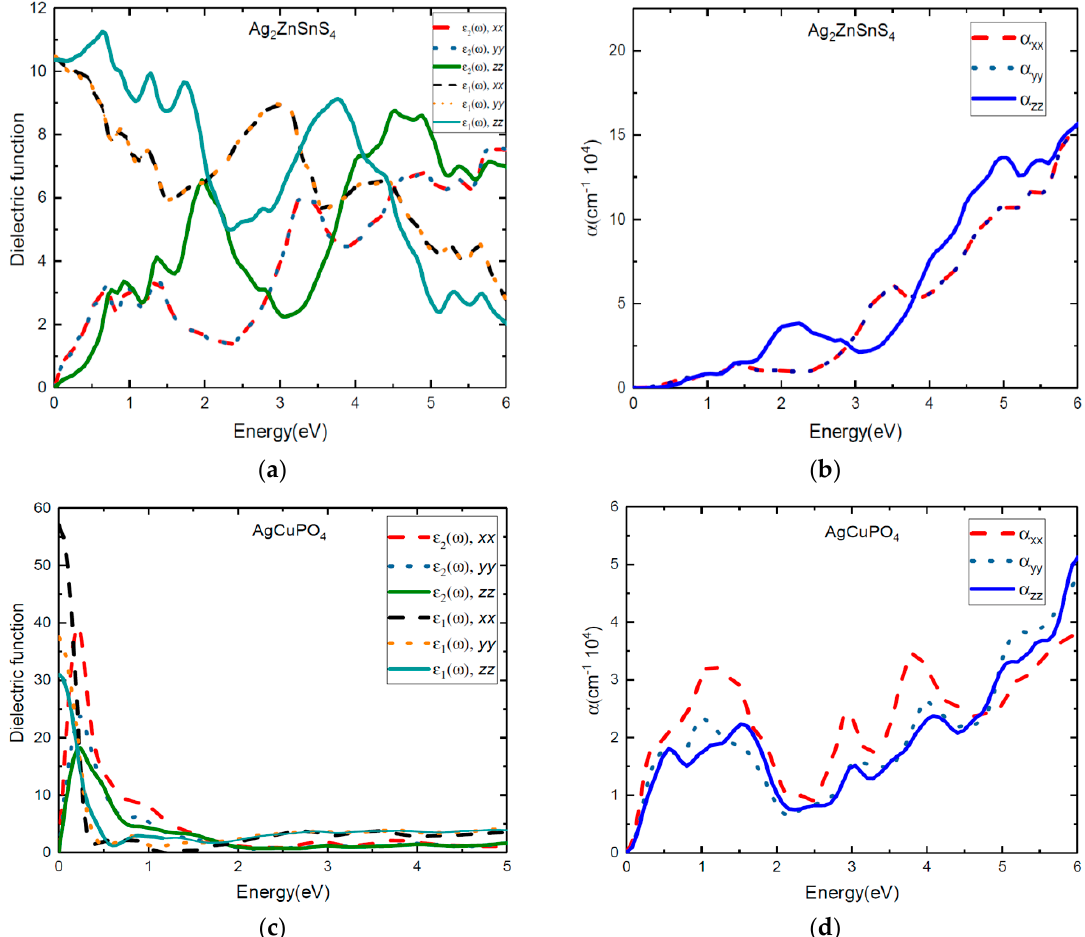
Figure 7. Calculated dielectric function ( a , c ) and absorption coefficients ( b , d ) of AgCuPO 4 and Ag 2 ZnSnS 4, respectively along the x , y , and z directions. Table 4. Calculated static dielectric constants from optical studies for Au 2 Cs 2 I 6, Ag 2 GeBaS 4, Ag 2 ZnSnS 4 , and AgCuPO 4. The supercell size used for the phonon study and the calculated zero-point energy (ZPE) for the studied compounds are also listed below.